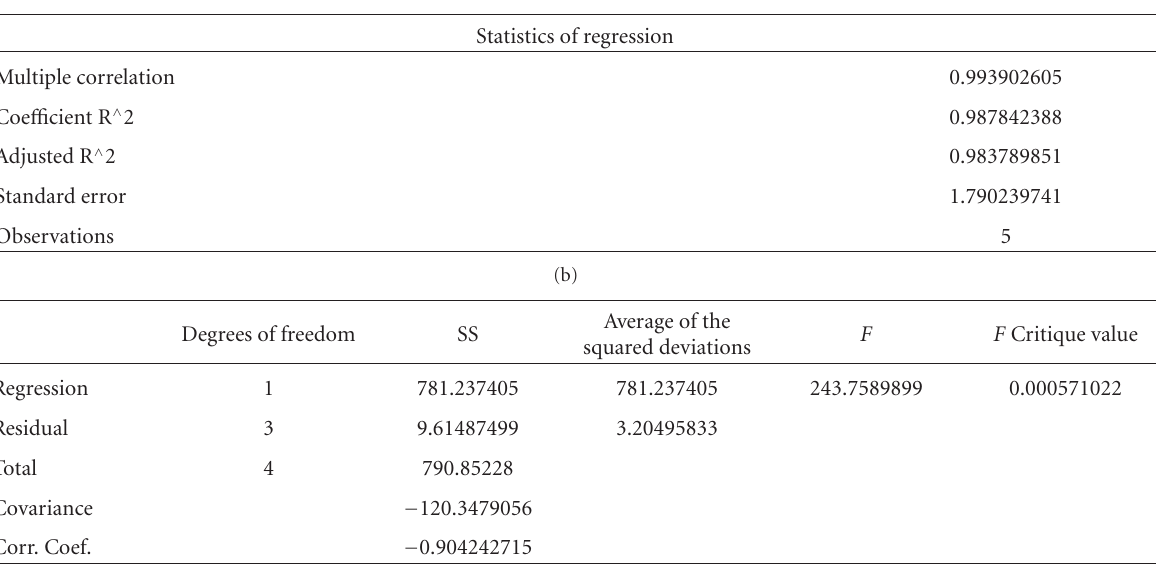
Table 3: Analyses of variance and covariance for SSR and porosity